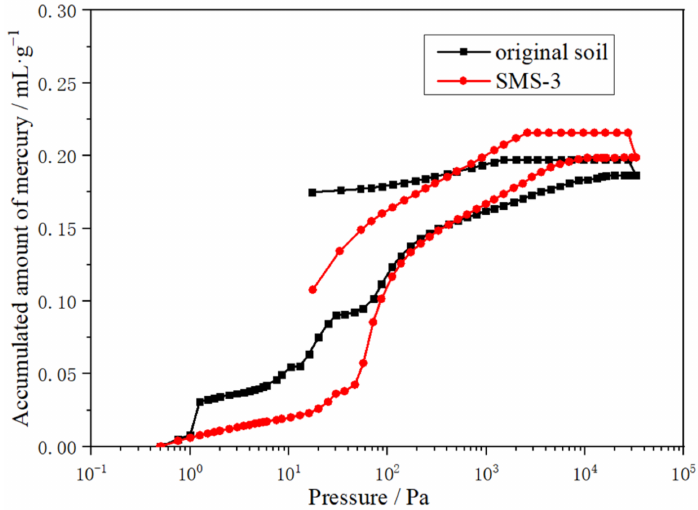
Figure 17. Soil pore size distribution density curve.